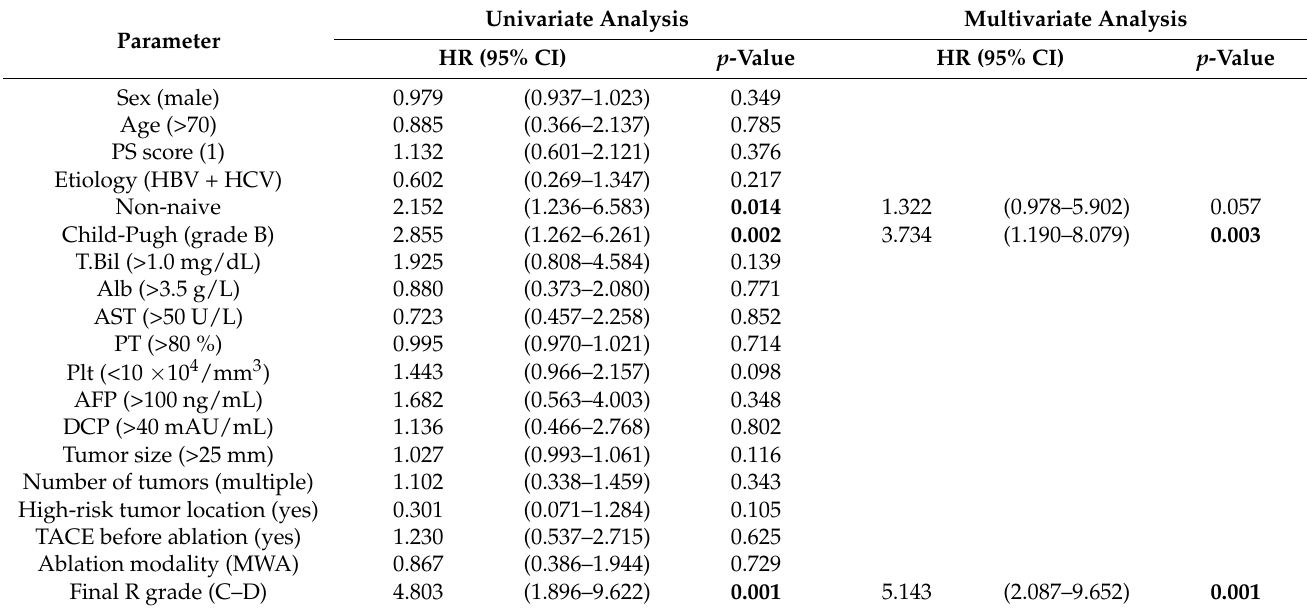
Table 3. Univariate and multivariable analyses of overall survival in the propensity score-matched cohort. Univariate Analysis Multivariate Parameter